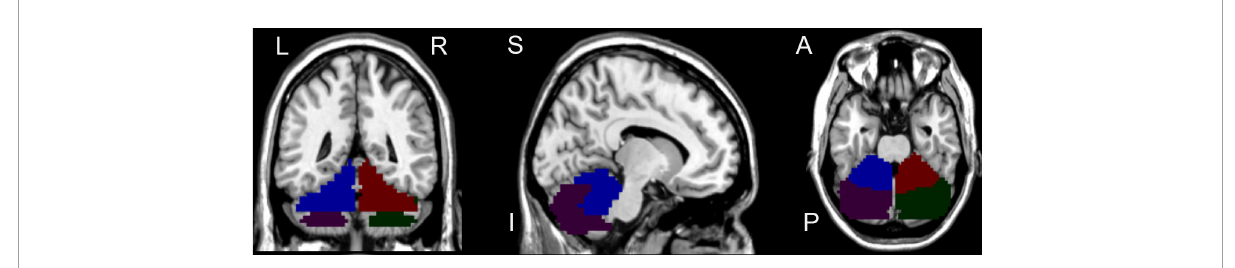
FIGURE2 Seed regions of interest for functional connectivity. Blue region represents left cerebellum anterior lobe; Purple region represents left cerebellum posterior lobe; Red region represents right cerebellum anterior lobe; Green region represents right cerebellum posterior lobe. L, left; R, right; S, superior; I, inferior; A, anterior; P, posterior.